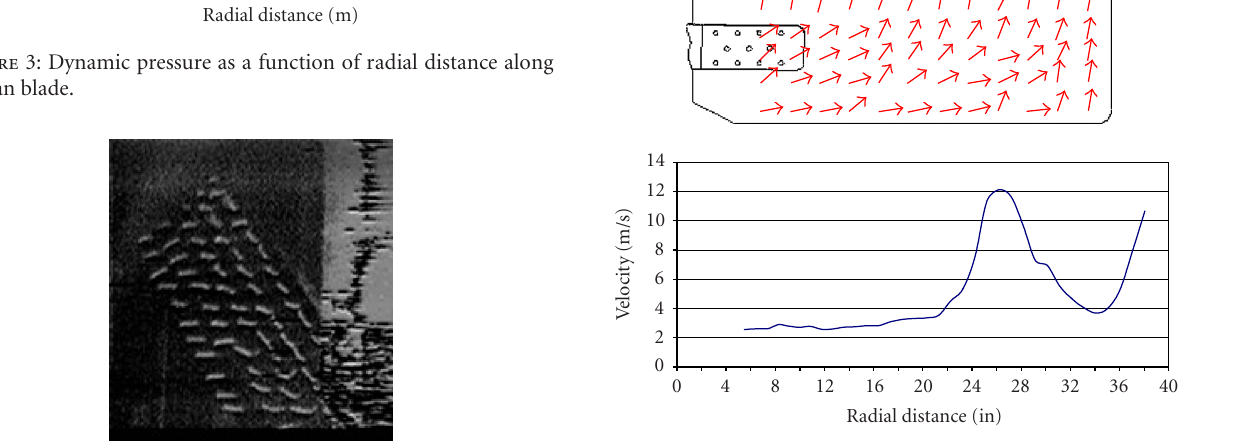
Figure 4: A still frame recorded by the high-speed camera for flow visualization.